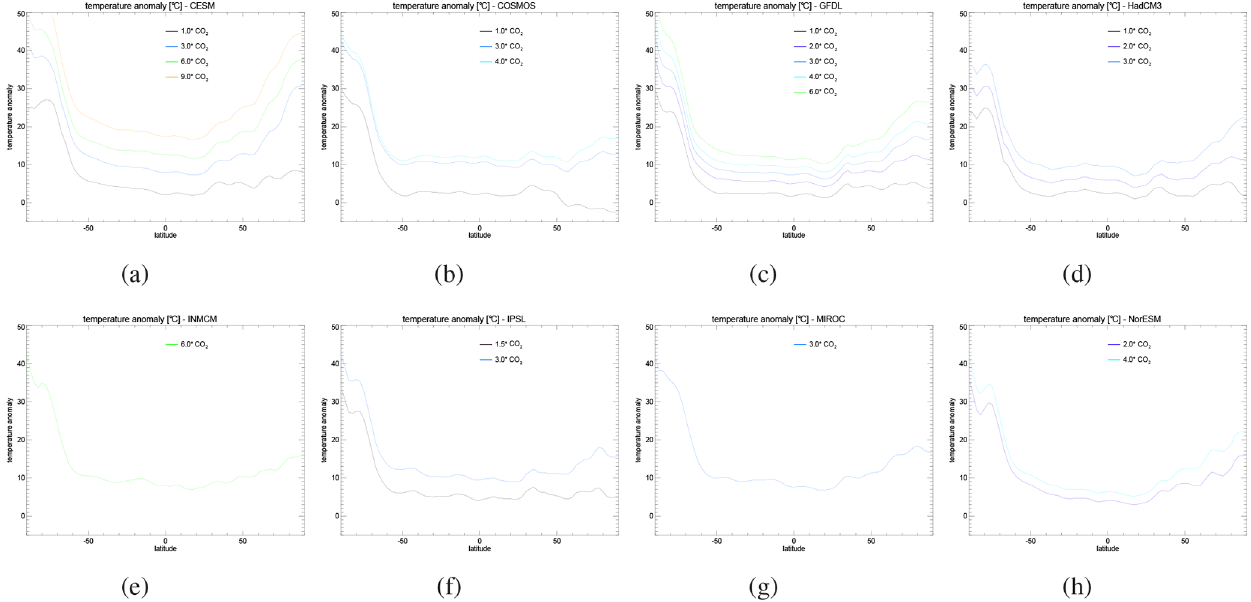
Figure 2. Zonal mean near-surface air temperatures in the DeepMIP simulations, as a function of latitude and prescribed atmospheric CO 2 concentration, expressed as anomalies relative to the equivalent preindustrial control for (a) CESM, (b) COSMOS, (c) GFDL, (d) HadCM3, (e) INMCM, (f) IPSL, (g) MIROC, and (h)